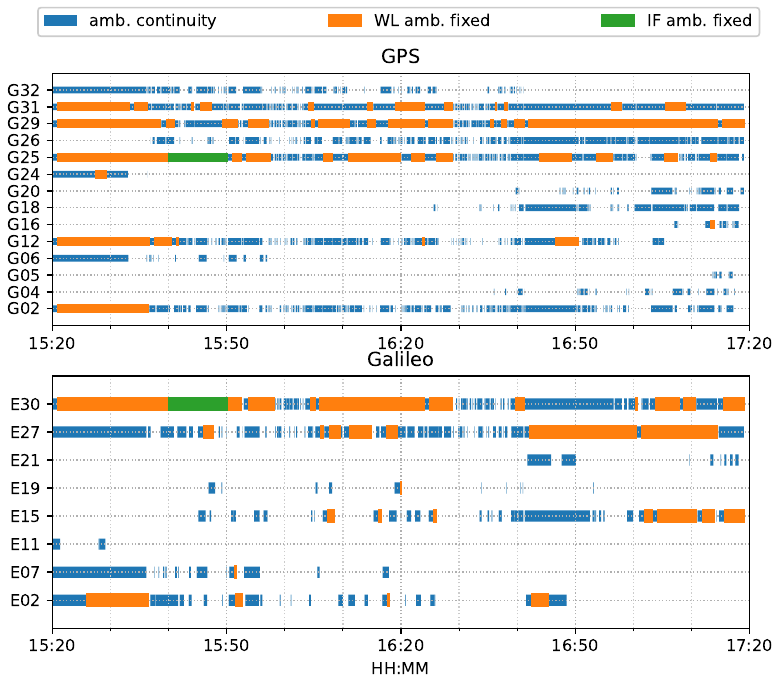
Figure 27. Phase ambiguity status of city center test on 27 January 2022. The van started moving at around 15:35 and stopped for about 15 min from around 16:35. As shown in Figure 28, the PPP solutions re-converged significantly several times. PPP + bias improved the results to some degree, but the frequent re-convergence continued to be an issue.The LCI solution mitigated the noisy spikes of the PPP, but the improvement were marginal. The bias correction added more aggregation in the up component. The TCI solutions, however, eliminated the divergence effectively and obtained the best performance during the test. TCI with bias correction improved the results further, especially for the up component. Figure 29 is an example of satellite view from 16:31:02 to 16:32:52. Vegetation was clustered along the curved path, and the reference solutions showed a lot of red states, indicating a challenging signal reception environment. As expected, the PPP solutions as well as as the bias corrected solutions had substantial inconsistencies along the